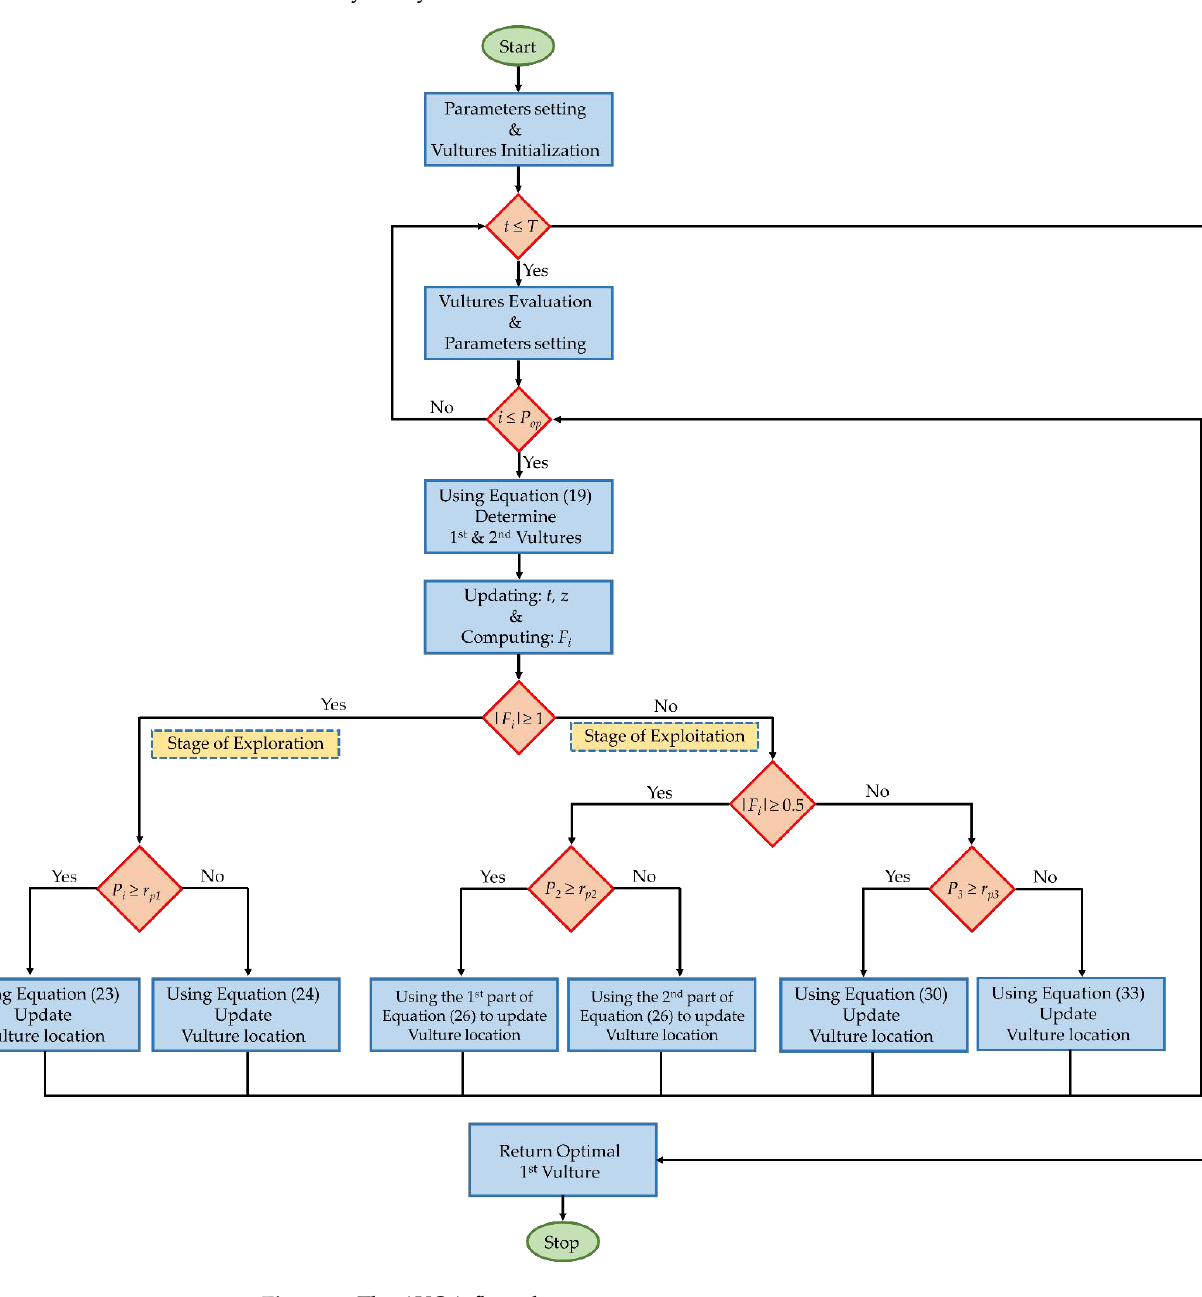
Figure 5. The AVOA flow chart.